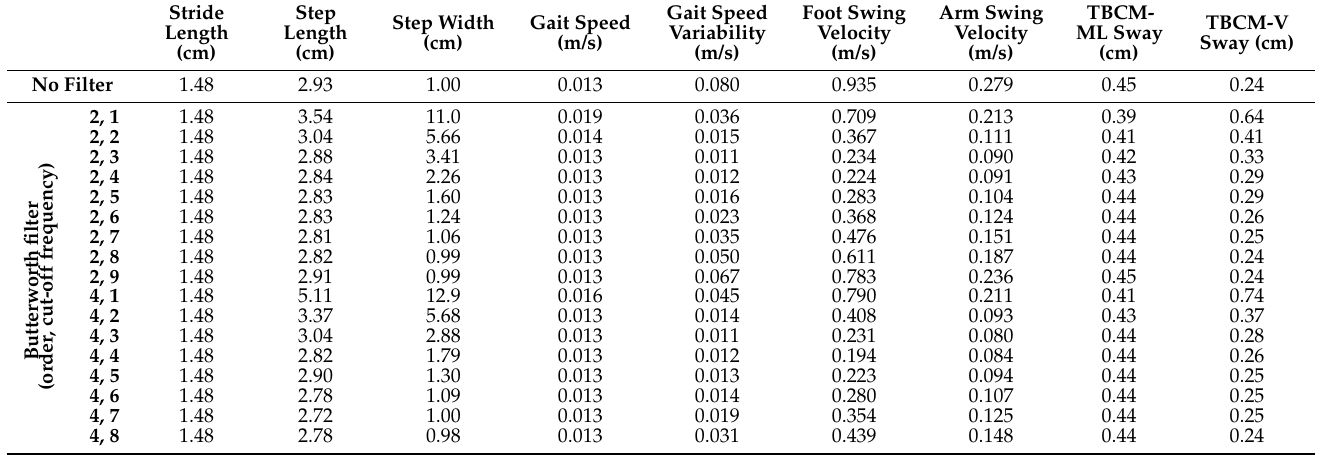
Table A1. Mean absolute error between Kinect and Qualisys for the spatiotemporal gait parameters, without filtering and when varying the Butterworth filter’s order between 2 and 6 (even integer values), and cut-off frequency between 1 and 9 Hz (integer values). The result corresponding to the chosen value for each gait parameter is underlined. TBCM-ML and TBCM-V stand for total body center of mass medio-lateral and vertical